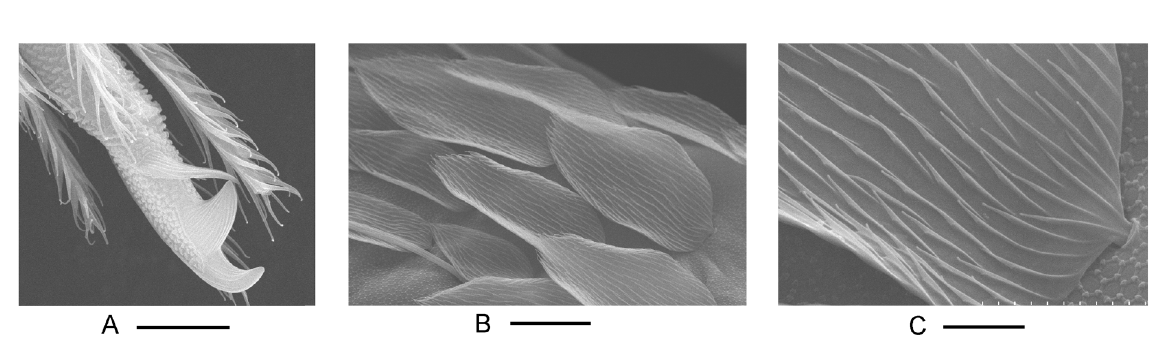
Fig. 4. Willowsia sexachaeta sp. nov. A . Distal part of dens and mucro. B – C . Scale(s). Scale bars: A = 5 μm; B = 10 μm; C = 2.5